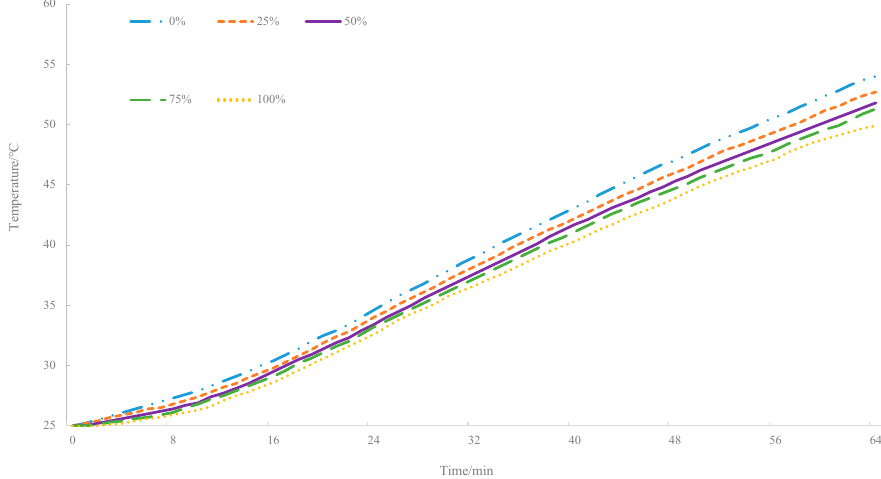
Figure 7. Bottom warming curves.